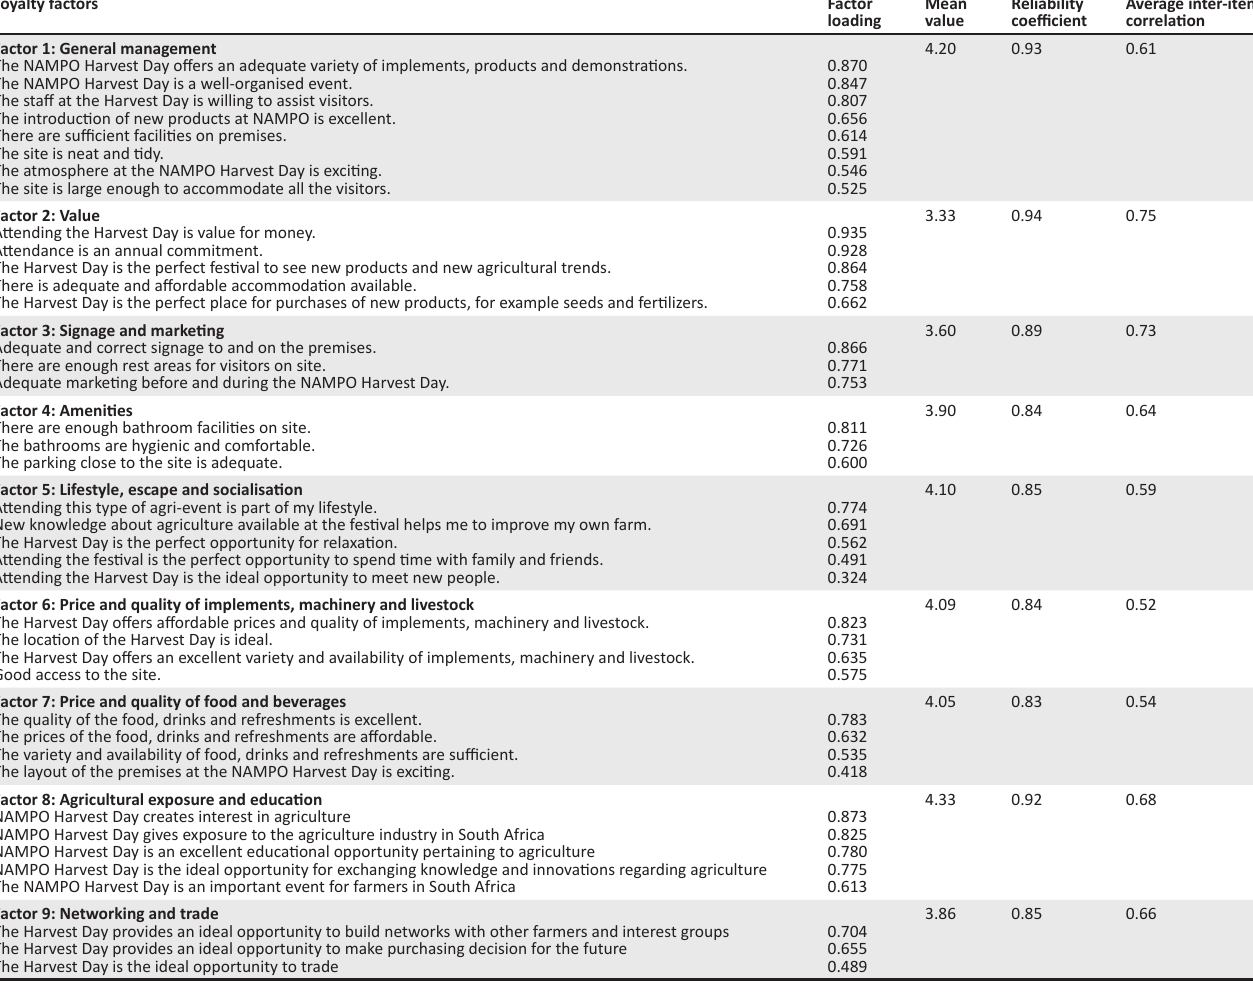
TABLE 3: Factor analysis results of the factors that have an influence on loyalty of the visitors to the NAMPO Harvest Day. Loyalty factors